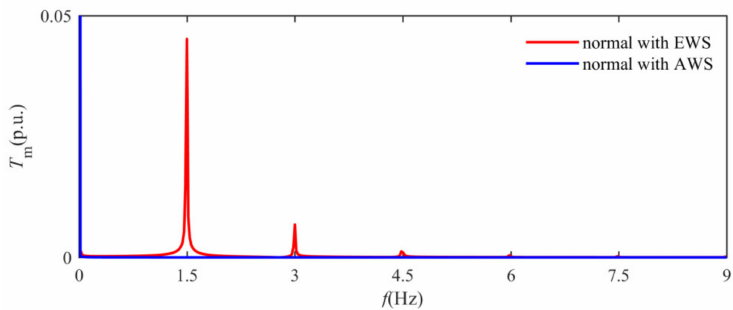
Figure 5. Fast Fourier transform (FFT) of the wind turbine (WT) mechanical